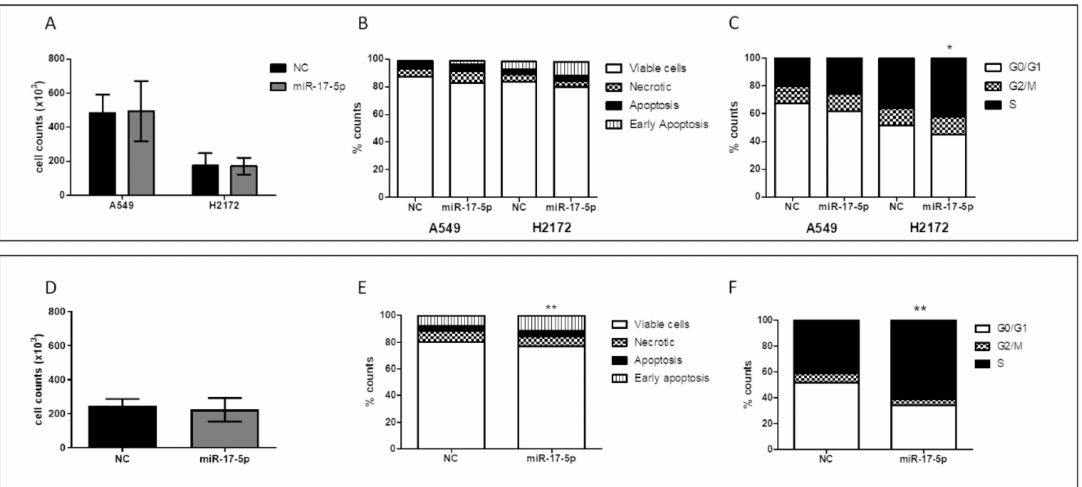
Figure 9. ( A ) Cell counts, ( B ) apoptosis and ( C ) cell cycle of A549 and H2172 cell lines after transfec- tion with miR-17-5p or scrambled control (NC) at 72 h. ( D ) Cell counts, ( E ) apoptosis and ( F ) cell cycle of H2172 NSCLC cell line after transfection with miR-17-5p or NC at 96 h. Cell counts are expressed as the mean ± standard deviations (four experiments). Stacked plots are the mean of four different experiments. Standard deviation was below 5% of the mean. * p -value < 0.05; ** p -value < 0.005.